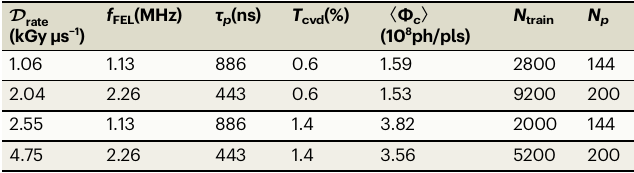
Table 1 | Measurement parameters